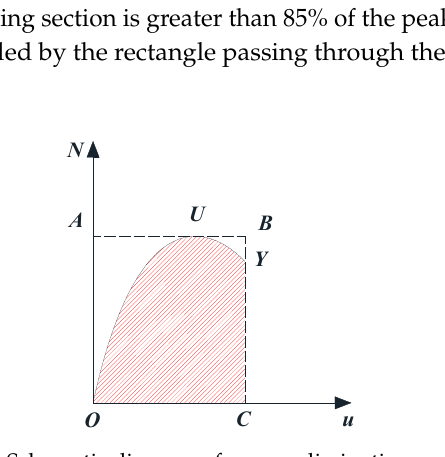
Figure 17. Schematic diagram of energy dissipation coefficient.